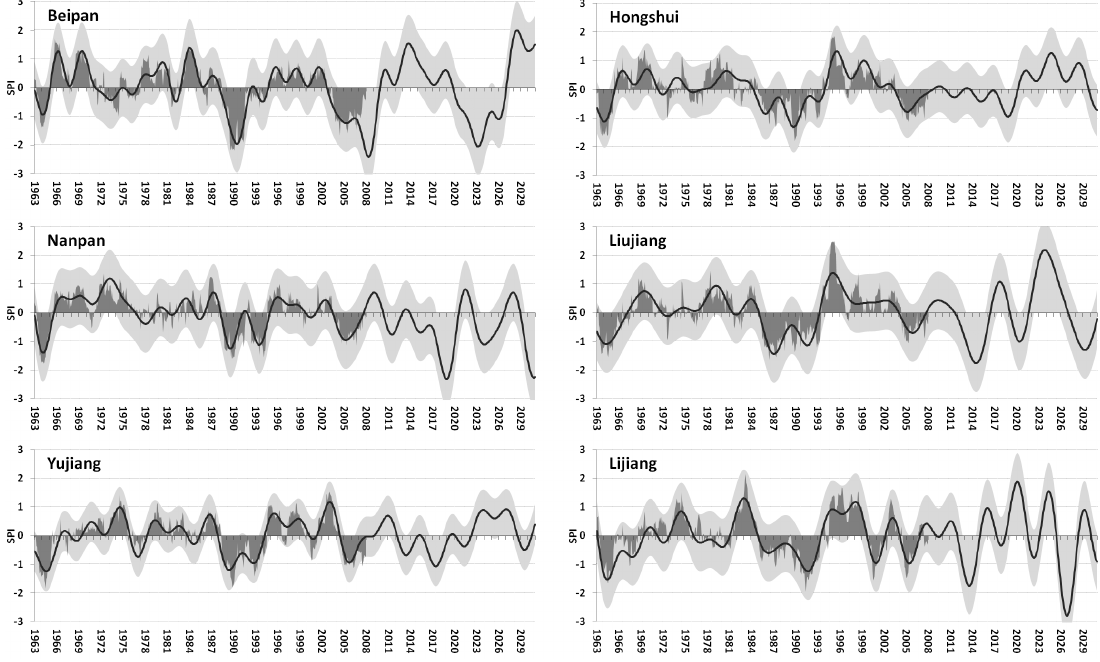
Fig. 14. Observed (dark grey shadings) and reconstructed time series (black line; confidence interval = light grey shading) plus extrapolation (starting in 2007) of the SPI-24 of the six sub-basins in the Xijiang River basin 1963–2030.